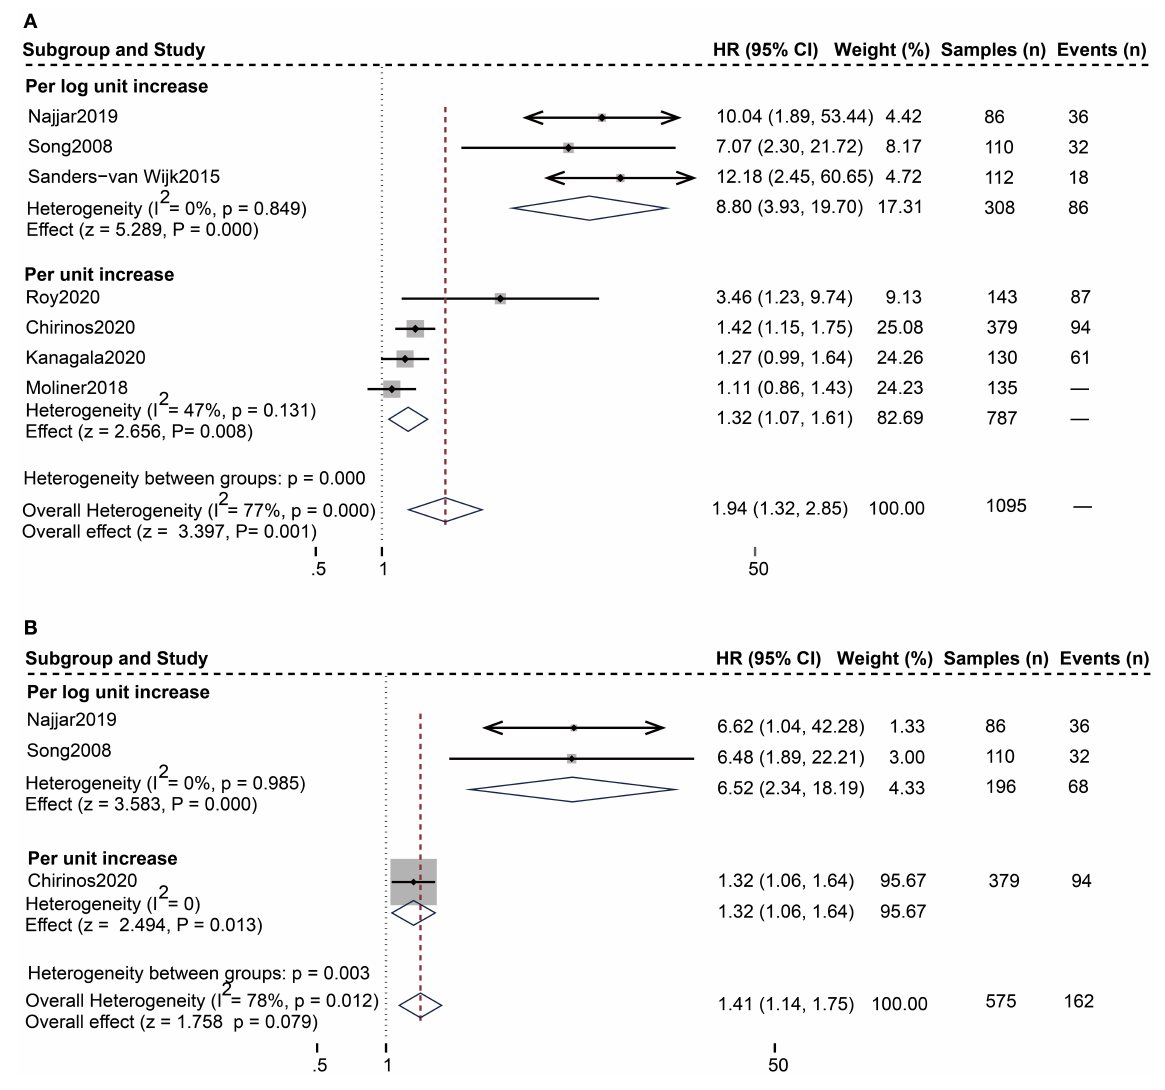
FIGURE3 Forest plot of the association between serum sST2 and the composite outcome of all-cause death and HF hospitalization. (A) Univariate analysis in the prediction of the composite outcome of all-cause death and HF hospitalization. (B) Multivariate analysis in the prediction of the composite outcome of all-cause death and HF